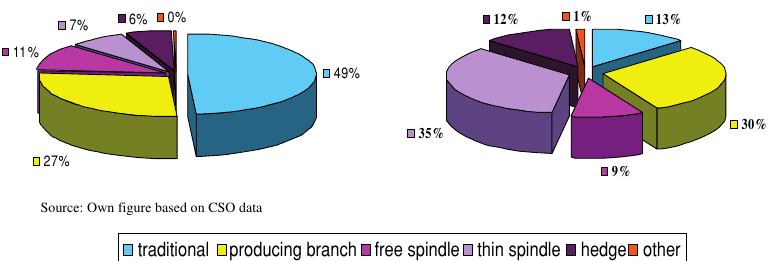
Figure 5: The cultivation methods of apple orchards in West Transdanubia and the Northern Great Plain